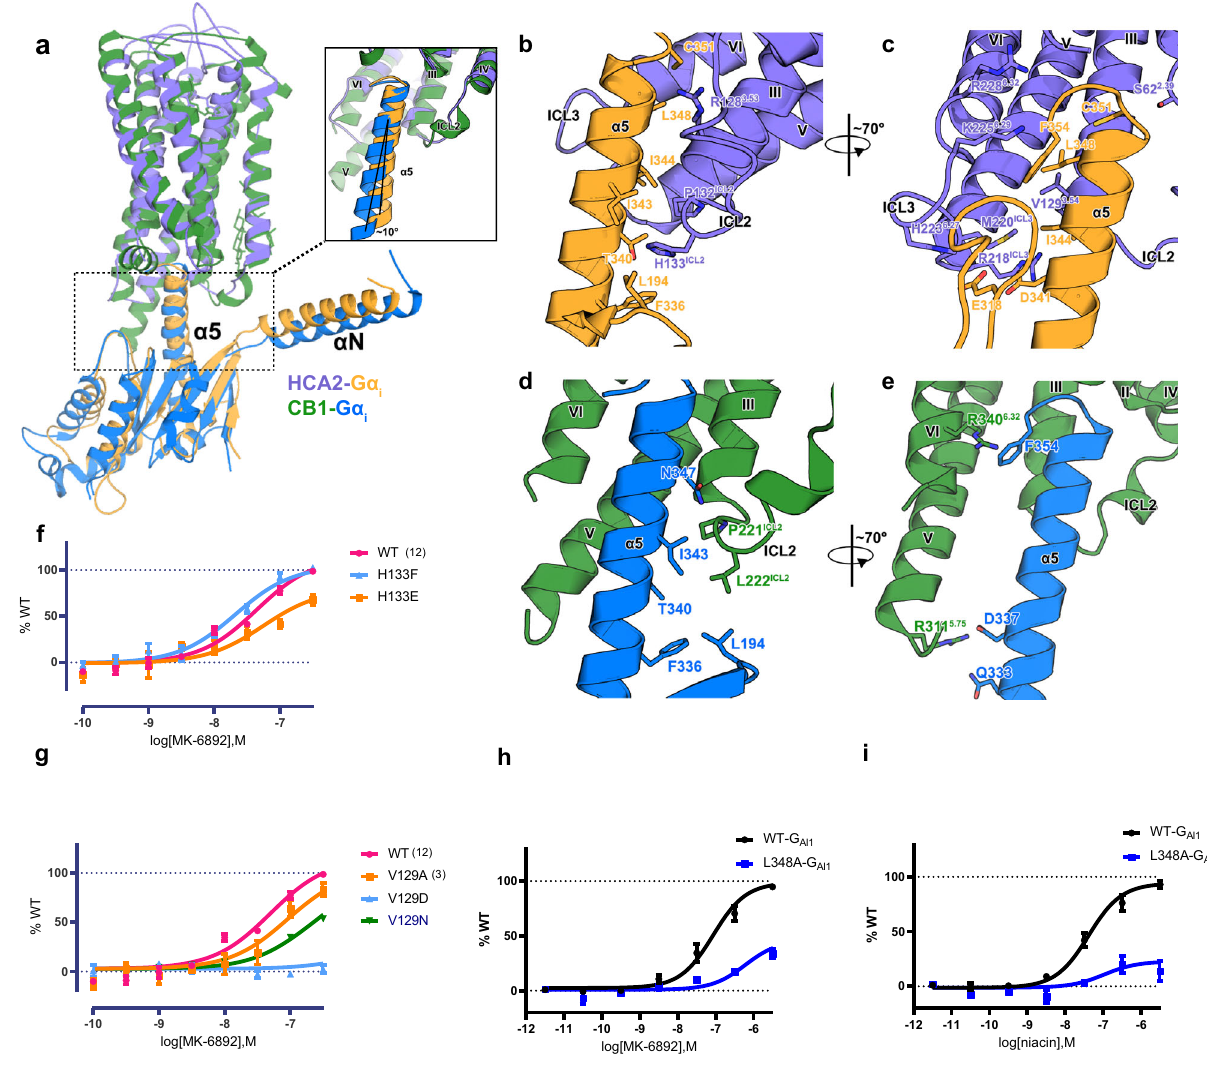
Fig. 3 | Comparison of HCA2-G i complex with CB1-G i complex in G i protein binding. a Relative position of G α i from HCA2-G i complex (orange) and CB1-G i complex (blue), aligned on receptor. The zoomed in view of G i and receptor interface is shown on the right. b, c The binding interface of HCA2 (light purple) withG α i (orange)andinteractingresiduesfrom α 5helixofG α i andadjacentICLand